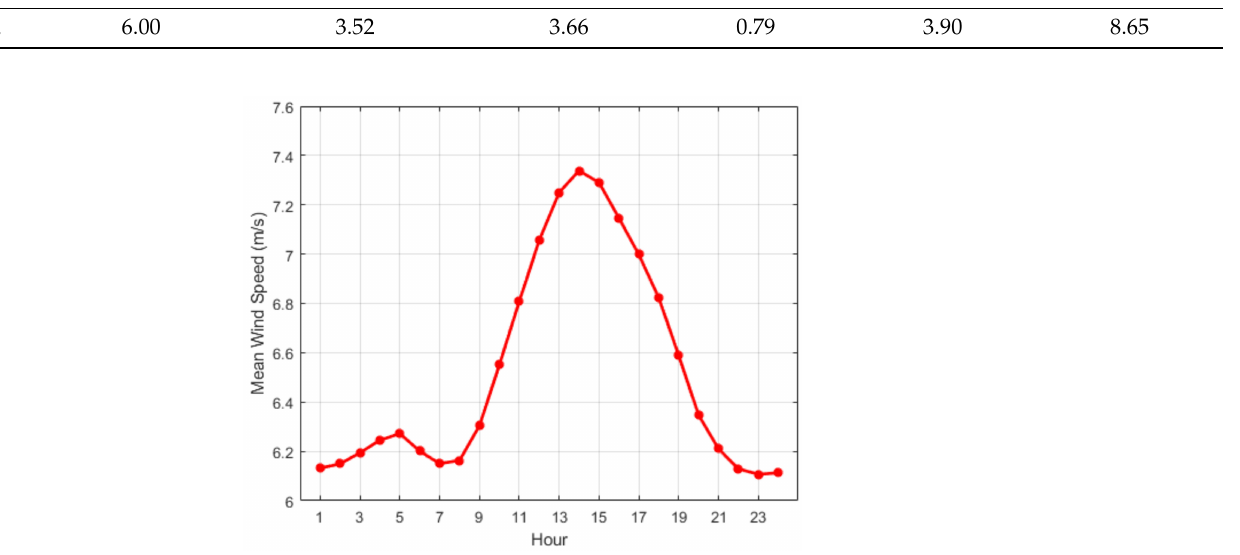
Figure 1. Mean wind speed for each hour considering all the data.